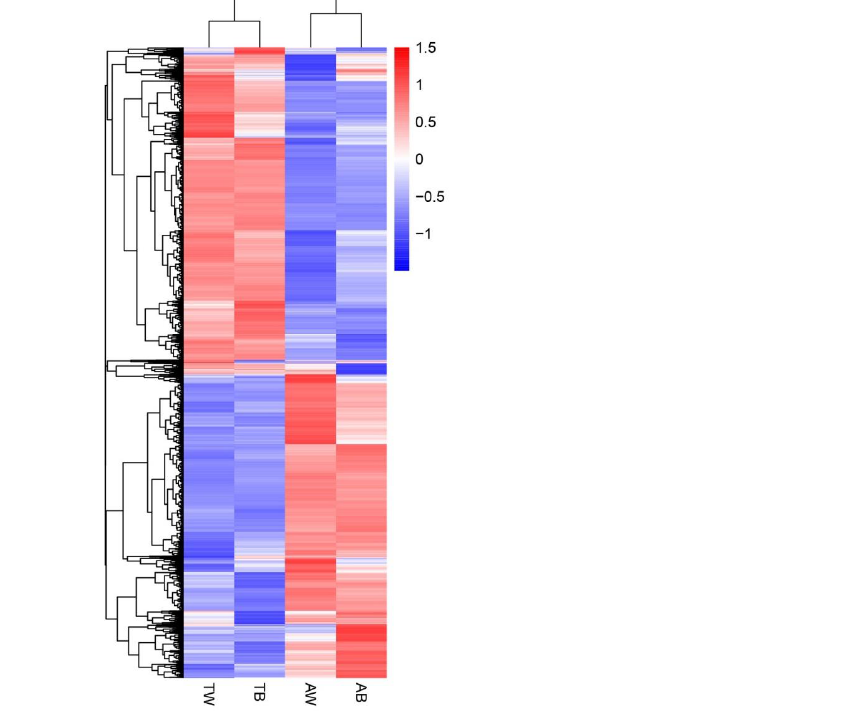
Figure 6. Venn diagram of differentially expressed genes in mink of ( A ) different hair colors show- ing the overlap between two age groups and ( B ) different age groups showing the overlap between two coat color groups.